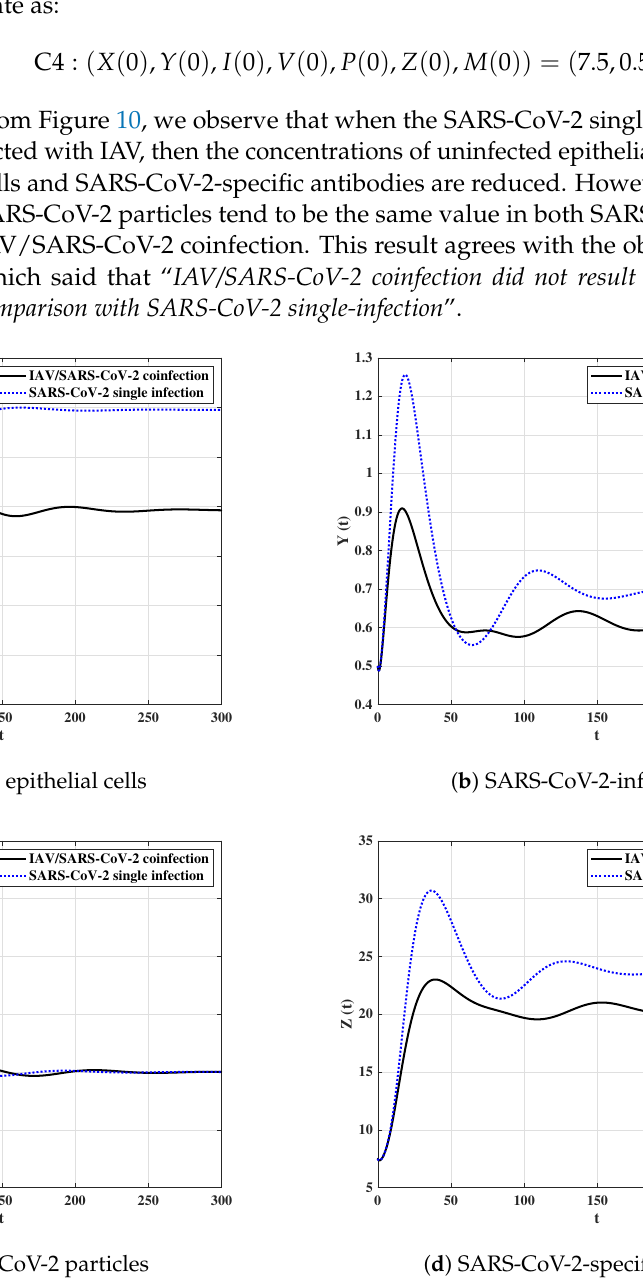
Figure 10. Comparison between the solutions of SARS-CoV-2-single-infection model and IAV/SARS- CoV-2 coinfection